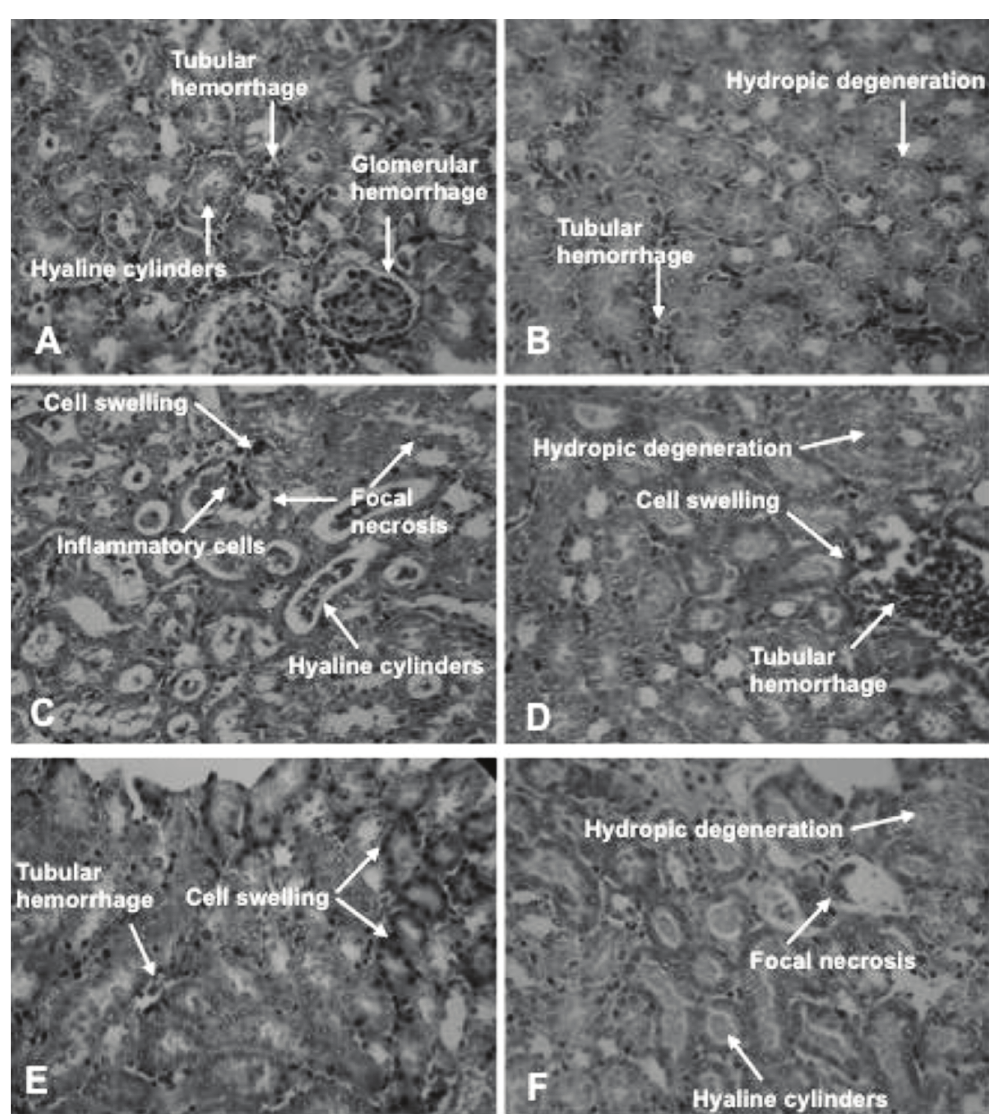
Figure 5 - Histology of kidneys removed from untreated or N -phthaloyl amino acid derivatives-treated mice with 50 mg/kg/day after 7 days. A – Control (4 % DMSO); B – Thalidomide; C – 5-Fluorouracil (25